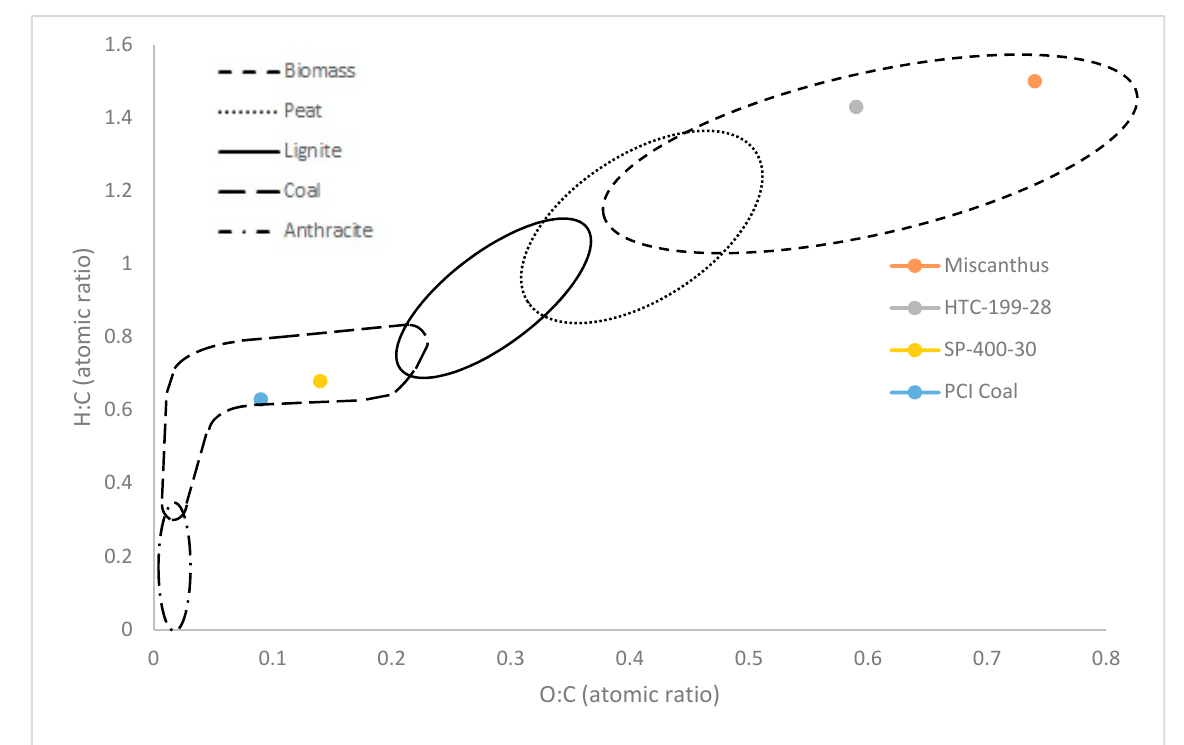
Figure 4. Van-Krevelen diagram showing different atomic O:C and H:C ratios of different samples.